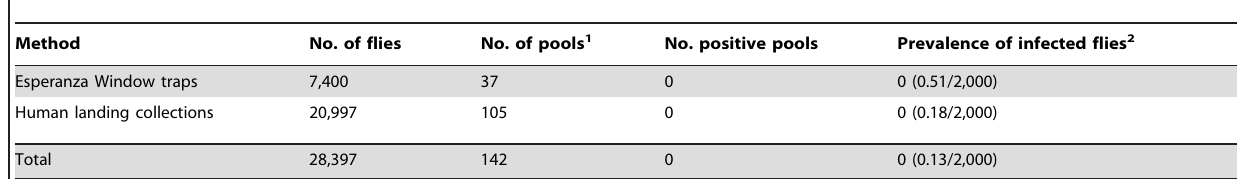
Table 2. Results of PCR pool screening for collected